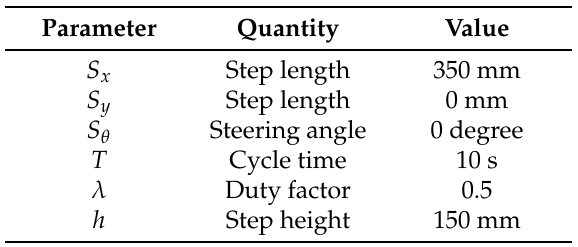
Table 5. Walking